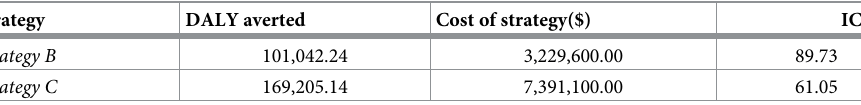
Table 14. ICER of control strategies in the order of DALY averted.